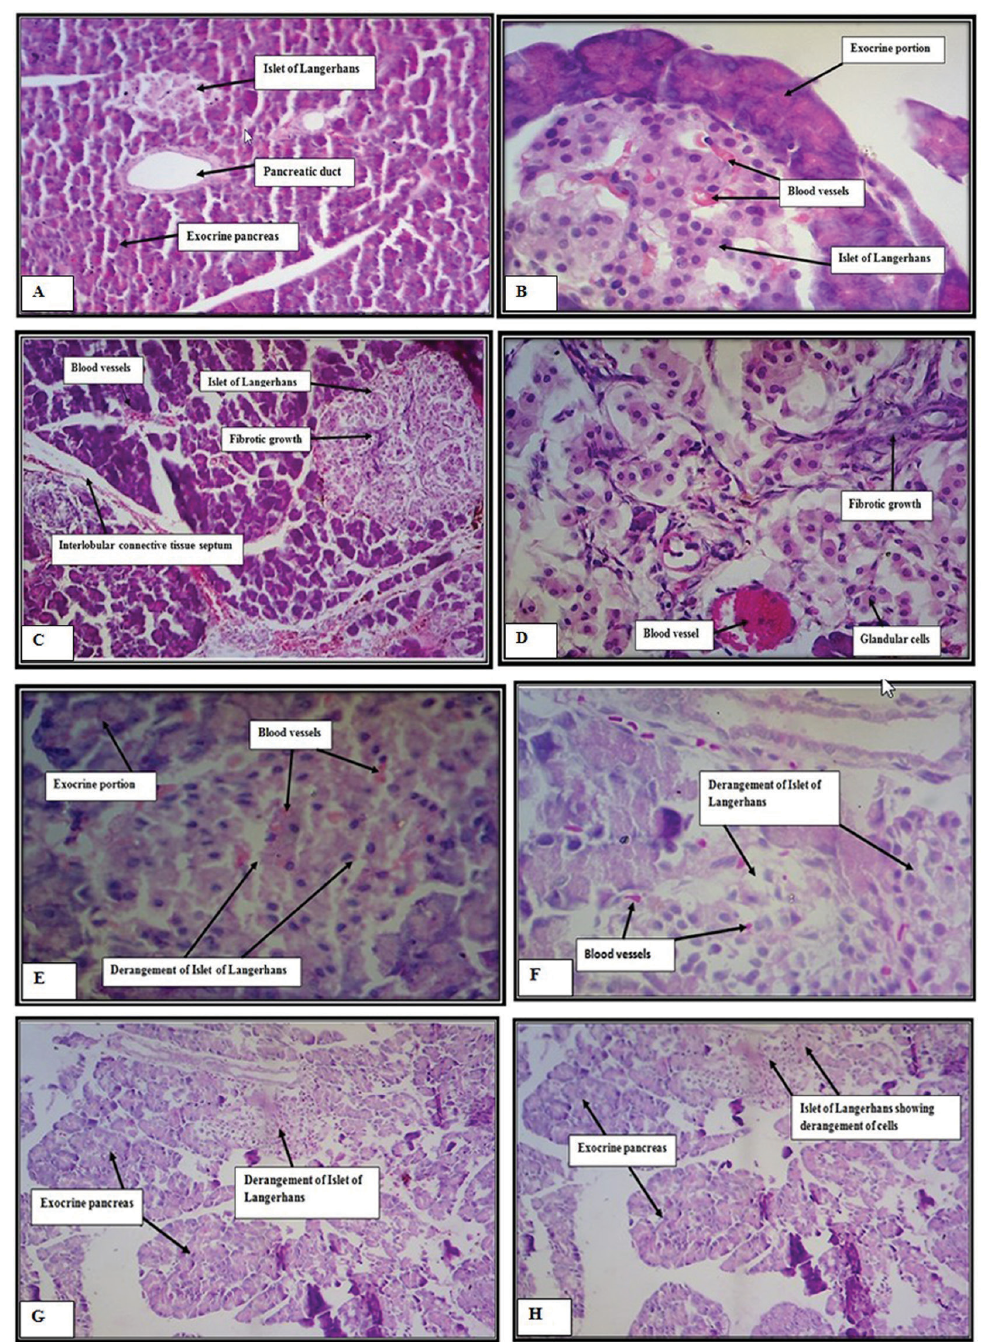
FIGURE 1 - (A-D): Effect of normal saline and olanzapine on the pancreas of rats (H & E, 100x, 400x, 5μ): Representative image of pancreas of rats treated with normal saline (A & B) orally for three weeks showing islets of Langerhans, packed as compact and intact glandular mass. Photomicrographs of a section (5 μm) of pancreas from a rat treated with olanzapine (C & D) (5 mg/kg/d for the first eight weeks, 10 mg/kg/d in next four weeks and 15 mg/kg/d in the last two weeks), showing nodular appearance of islet of Langerhans due to fibrotic growth with derangement of beta cells. Effect of risperidone on the pancreas of rats (H & E, 100x, 400x,5 μ) (E-F): Representative images of pancreas of rats treated with risperidone (2.5 mg/kg/d) orally for three weeks showing derangement of islets of Langerhans, lacking compaction of glandular cells as compared to rats treated with normal saline (A & B). Effect of streptozocin on the pancreas of rats (H & E, 100x, 400x,5 μ): Representative images of pancreas of rats treated with streptozocin (G ‑H) (50 mg/kg/d/ip) showing derangement of islets of Langerhans, lacking compaction of glandular cells as compared to rats treated with normal